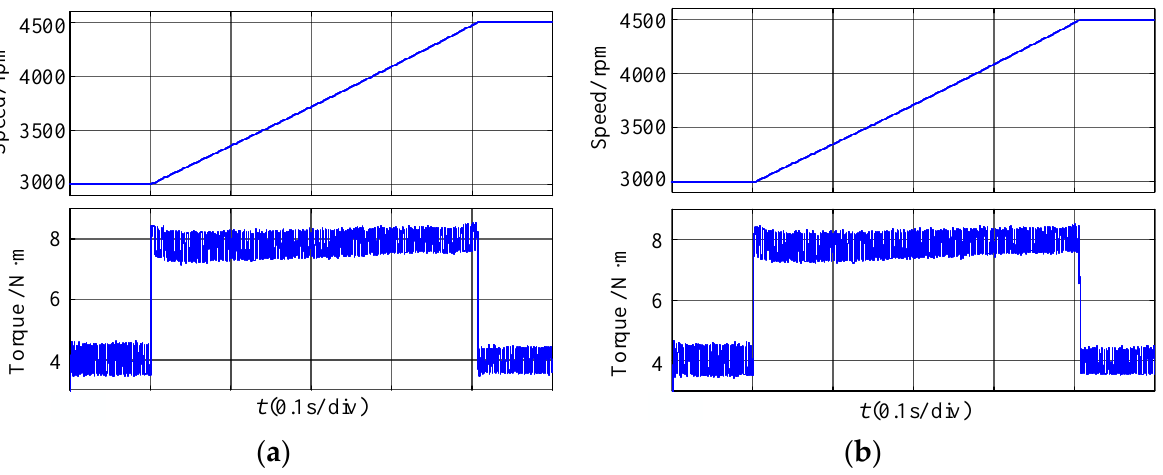
Figure 20. The dynamic simulation waveforms when the speed changes from 3000 rpm to 4500 rpm.